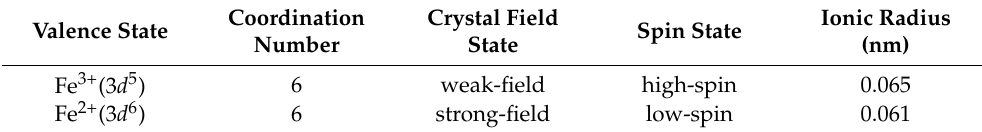
Table 4. The state and ionic radius of iron ions in corundum ( α -Al 2 O 3 ). Ionic Radius Coordination Crystal Field Spin State Valence State (nm) Number State Fe 3+ (3 d 5 ) 6 weak-field high-spin 0.065 Fe 2+ (3 d 6 ) 6 strong-field low-spin